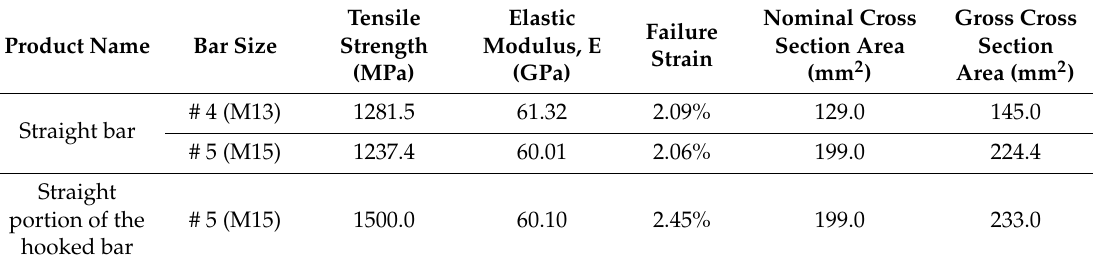
Figure 2. Views of the developed GFRP bar with 180° hook. ( a ) length of the hook; ( b ) radius of the hook. Table 1. Properties of GFRP bars as obtained from the manufacturer.